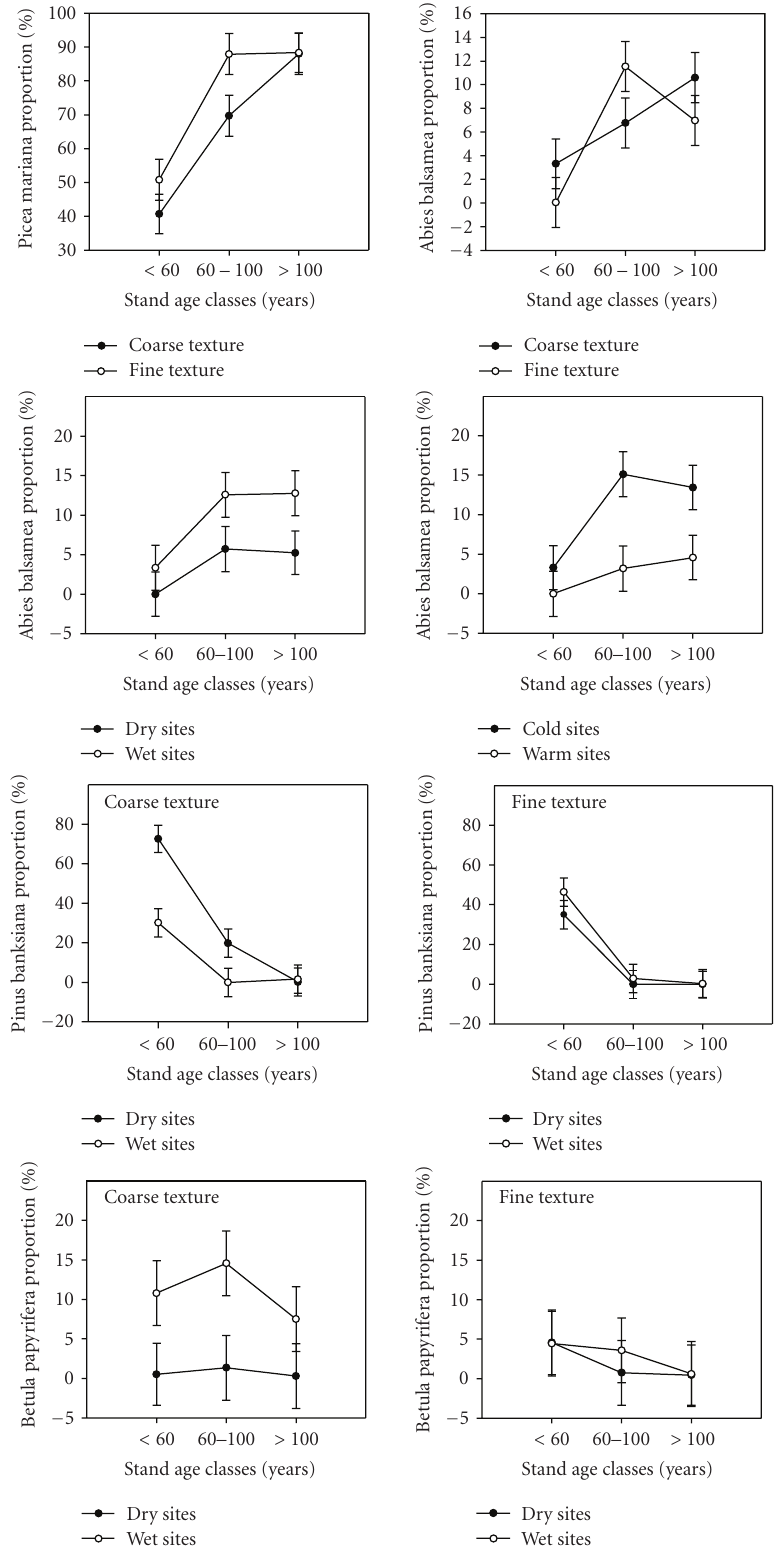
Figure 3: Relationships between stand composition and stand age, air temperature, precipitation, and soil texture. Data from the first inventory